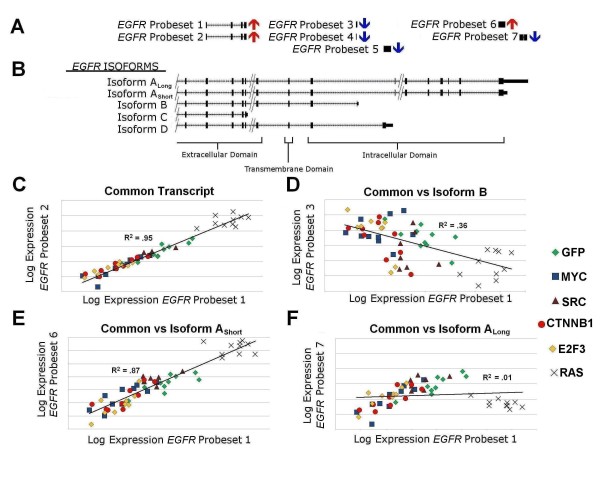
HRAS over-expression causes isoform specific regulation of Epidermal Growth Factor Receptor (EGFR) in human mammary epithelial cells. (A) Probesets on the Affymetrix U133 2.0 plus array interrogate EGFR expression at seven different genomic locations. Up and down arrows indicate each probeset's expression changes in HRAS over-expression compared to GFP controls. Probeset 5 experienced a significant decrease in expression with HRAS over-expression, but was not expressed above background. B) UCSC genomic alignment of probesets and EGFR isoforms. Four previously observed EGFR isoforms (A, B, C and D) are shown with exons represented as black boxes and introns as hashed lines. Extracellular, transmembrane, and intracellular domain regions are shown below the alignment. C-F) Scatter plots of logged expression levels of all 55 samples (GFP, MYC, SRC, CTNNB1, E2F3, and HRAS) for selected pairs of probesets C) Probesets 1 and 2 target a transcript region common to all major isoforms and exhibit highly correlated expression (R2 = .95). D) Probesets 1 and 3 target the common region vs. isoform B specific region and demonstrate a weak inverse relationship (R2 = .36). E) Probesets 1 and 6 interrogate the common vs. AShort isoform region, demonstrating a high degree of correlation across all samples (R2 = .87). F) In contrast, probesets 1 and 7 interrogate common and ALong isoform region and are not correlated (R2 = .01) due to the HRAS induced 3'UTR shortening of EGFR A transcripts.